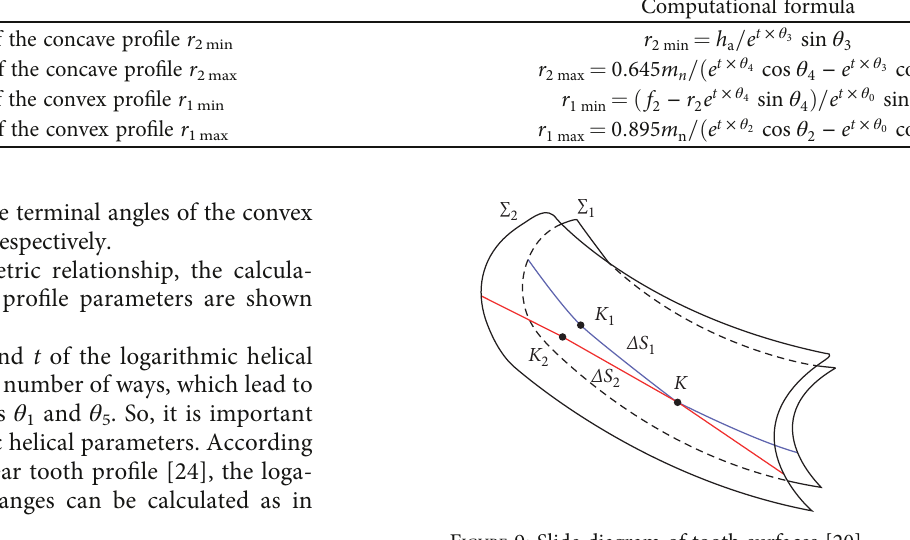
F IGURE 9: Slide diagram of tooth surfaces